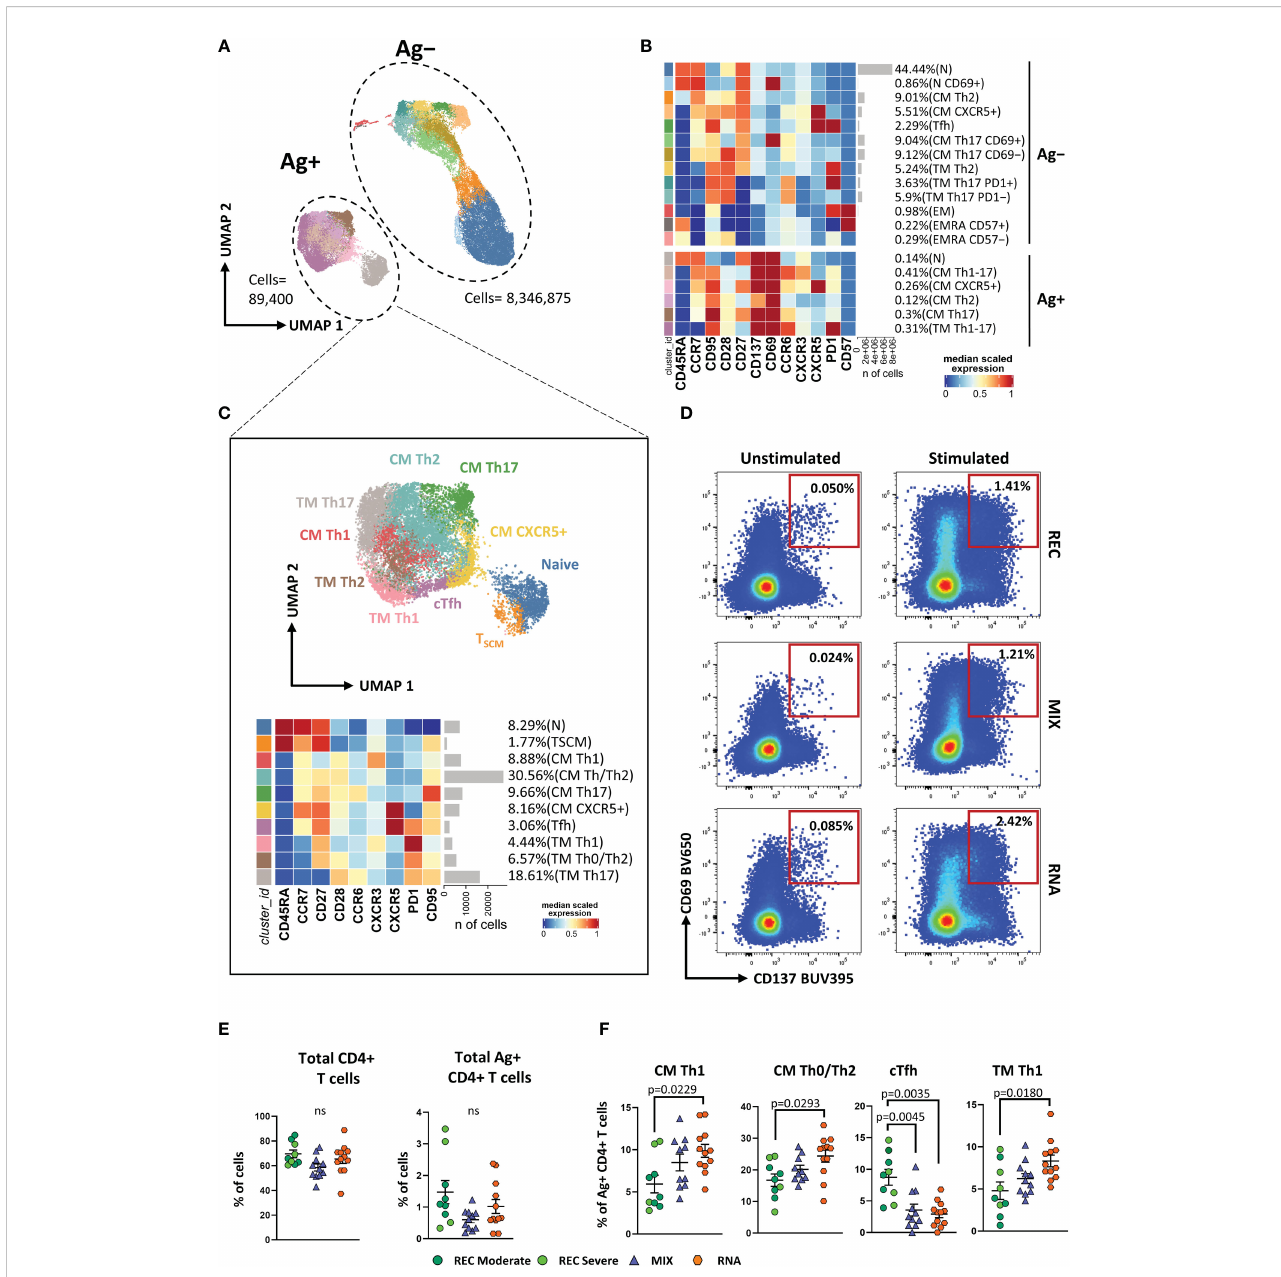
FIGURE 1 Immune phenotyping of antigen-speci fi c CD4 + T cells. (A) Uniform Manifold Approximation and Projection (UMAP) plot shows the 2D spatial distribution of 8,436,275 cells from nine donors who recovered from SARS-CoV-2 infection (REC, severe = 4 and moderate = 5) and 23 vaccinated donors (MIX = 11 and RNA = 12) embedded with FlowSOM clusters. Ag + , antigen-speci fi c CD4 + T cells; Ag − , non-antigen-speci fi c CD4 + T cells. (B) Heatmap of the median marker intensities of the 12 lineage markers across the 19 cell populations obtained with FlowSOM algorithm after the manual metacluster merging. The colors of cluster_id column correspond to the colors used to label the UMAP plot clusters. The color in the heatmap is referred to the median of the arcsinh marker expression (0 – 1 scaled) calculated over cells from all of the samples. Blue represents lower expression, while red represents higher expression. Light gray bar along the rows (clusters) and values in brackets indicate the relative sizes of the clusters. N, naive; T SCM , T stem cell memory; CM, central memory; TM, transitional memory; EM, effector memory; EMRA, effector memory reexpressing the CD45RA; cTfh, circulating T follicular helper cells. The black bar on the right is used to group Ag + or Ag − subpopulations. (C) UMAP and heatmap visualization of 10 manually merged antigen-speci fi c CD4 + T-cell clusters. (D) Representative dot plots showing manual gating analysis of Ag- speci fi c (CD137 + CD69 + ) CD4 + T cells after overnight stimulation with spike protein compared to unstimulated control [activation-induced marker assay (AIM assay)]. Numbers in the dot plots indicate the percentage of cells identi fi ed by manual gating. (E) Dot plots show the total percentage of antigen-speci fi c CD4 + T cells. Kruskal – Wallis test with Benjamini – Hochberg correction for multiple comparisons was used to test the differences among the three groups. (F) Dot plots show the cell percentage of the antigen-speci fi c CD4 + T cells. The central bar represents the mean ± SEM. Generalized linear mixed model (GLMM) test was used for the statistical analysis. Adjusted P-values are reported in the fi gure. ns, not signi fi